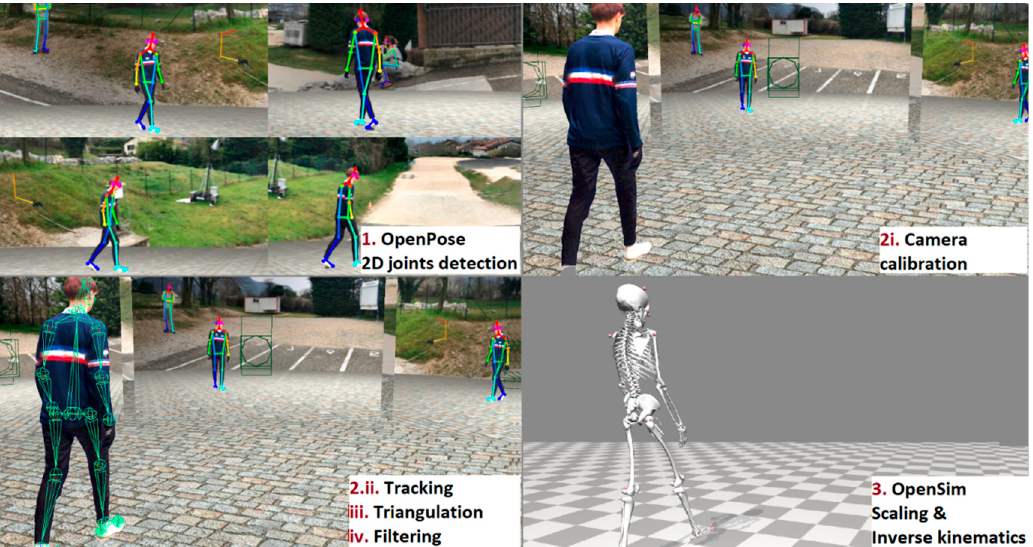
Figure 3. Pose2Sim full pipeline: (1) OpenPose 2D joint detection; (2i) camera calibration; (2ii–iv) tracking the person of interest, triangulating his coordinates, and filtering them; (3) constraining the 3D coordinates to a physically consistent OpenSim skeletal model.